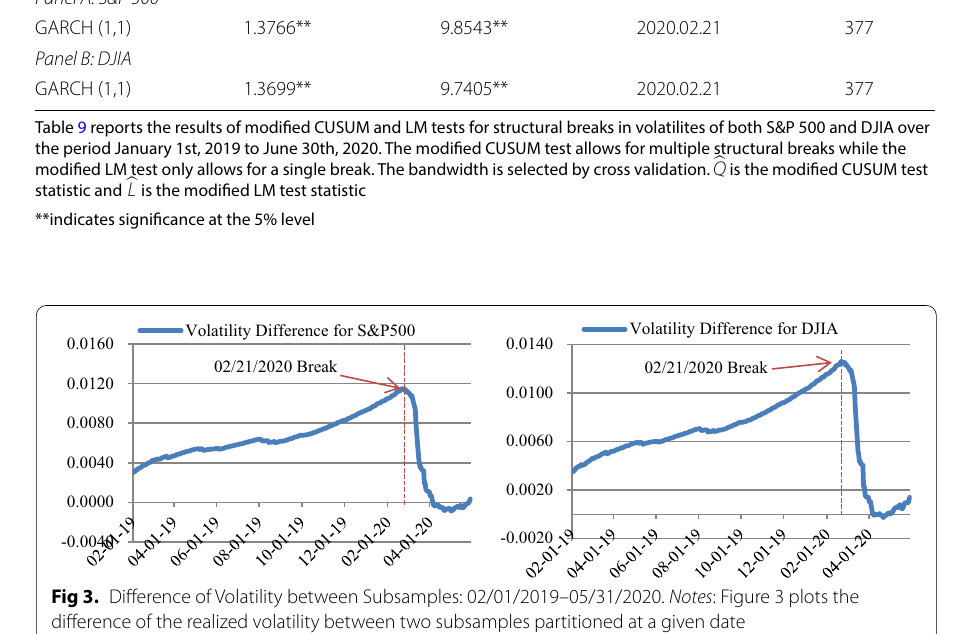
Table 9 Xu (2013)’s Test Statistics for Breaks: 01/01/2019–06/30/2020